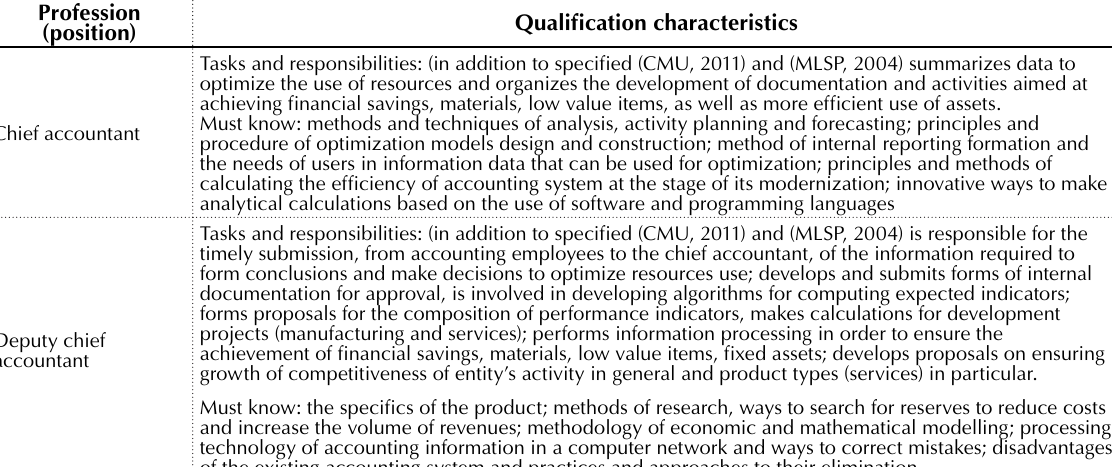
Table 1. Recommended qualification characteristics and responsibilities of the accounting service